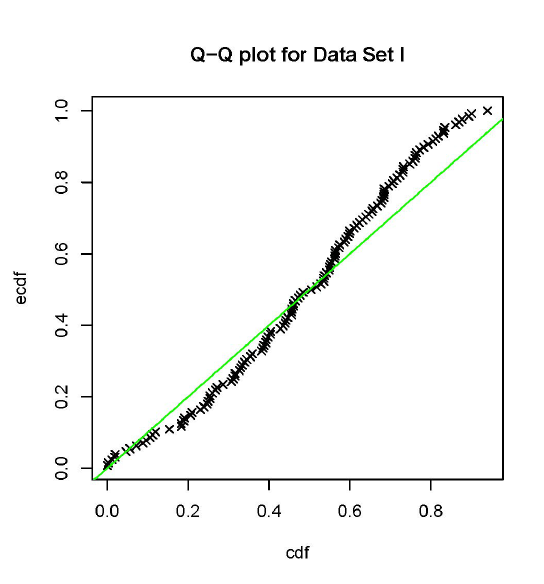
Figure 5 – QQ plot for the data